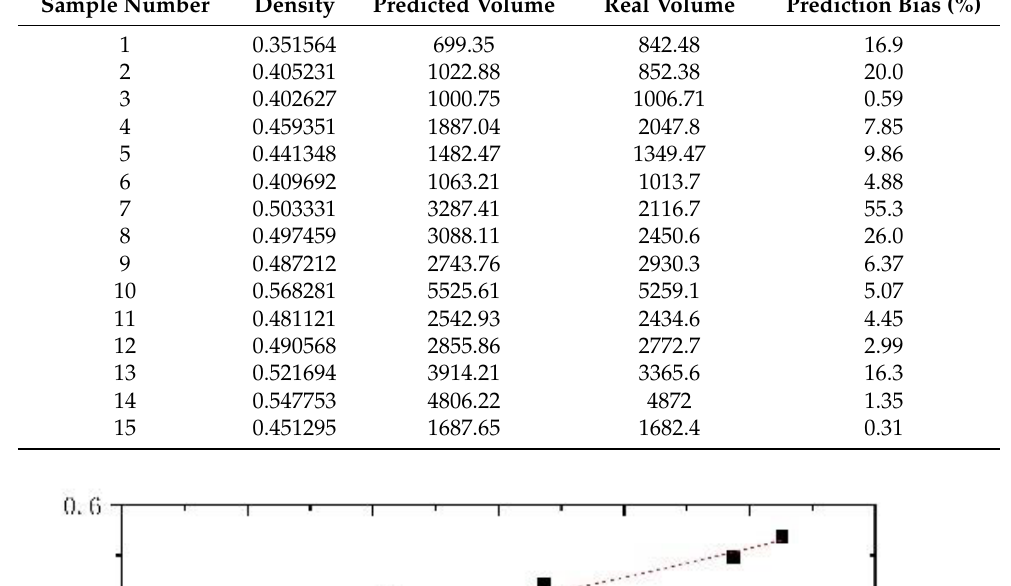
Table 1. Selected crystal samples for CIR testing.